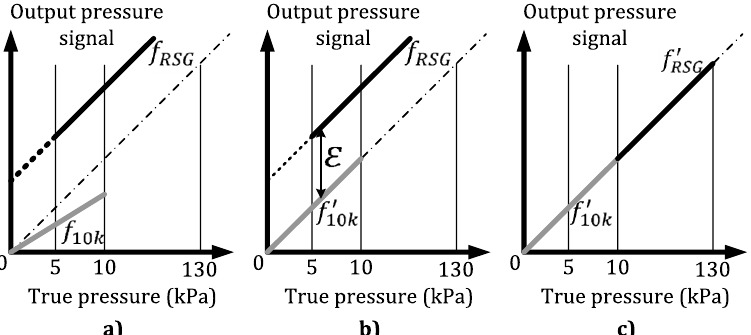
Fig. 8. Procedure to correct the working standard.The straight line passing through the origin with a slope equal to unity represents the output signal of the ideal instrument.Respective drifts of the RSG (in offset) and CDG (in slope) are voluntarily exaggerated for a greater clarity.